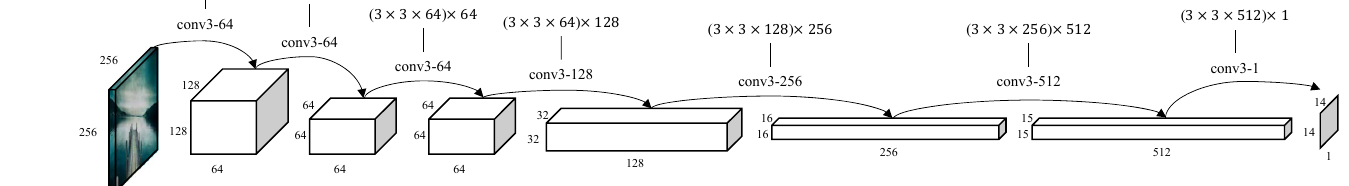
Figure 4. The architecture of our